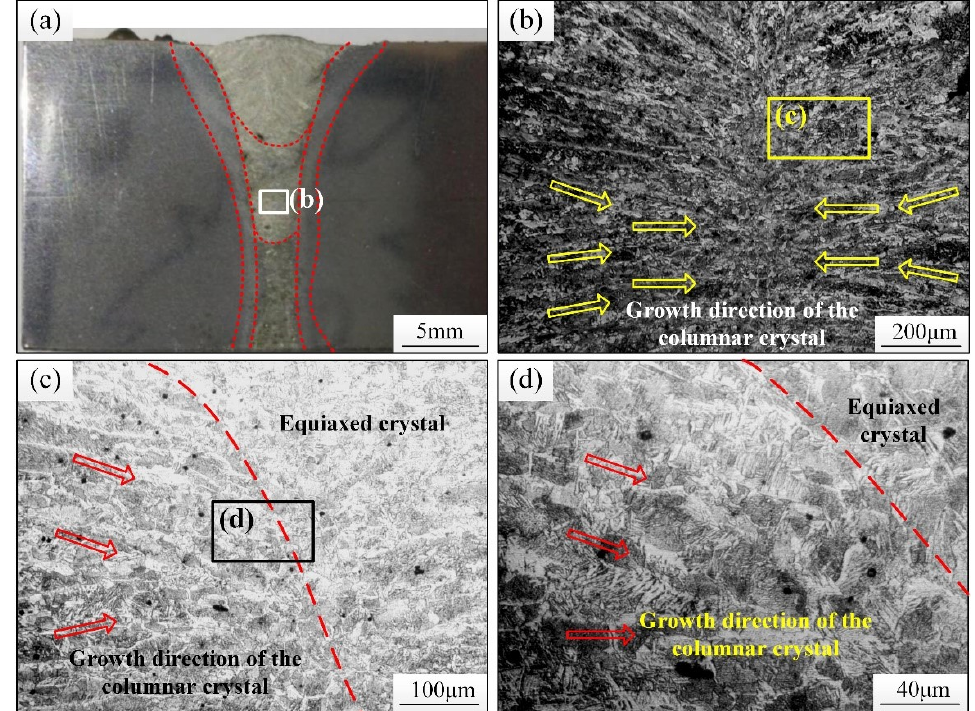
Figure 4. Microstructure morphology of WS: ( a ) macro morphology; ( b ) localized region marked in ( a ); ( c ) localized region marked in ( b ); ( d ) localized region marked in ( c ).